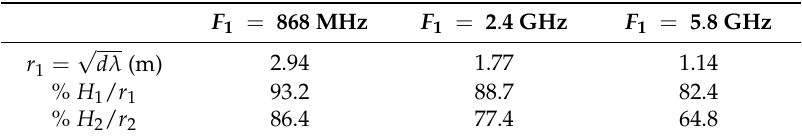
Table 1. Obstruction of the First Fresnel Zone (FFZ) in percentage w.r.t antenna